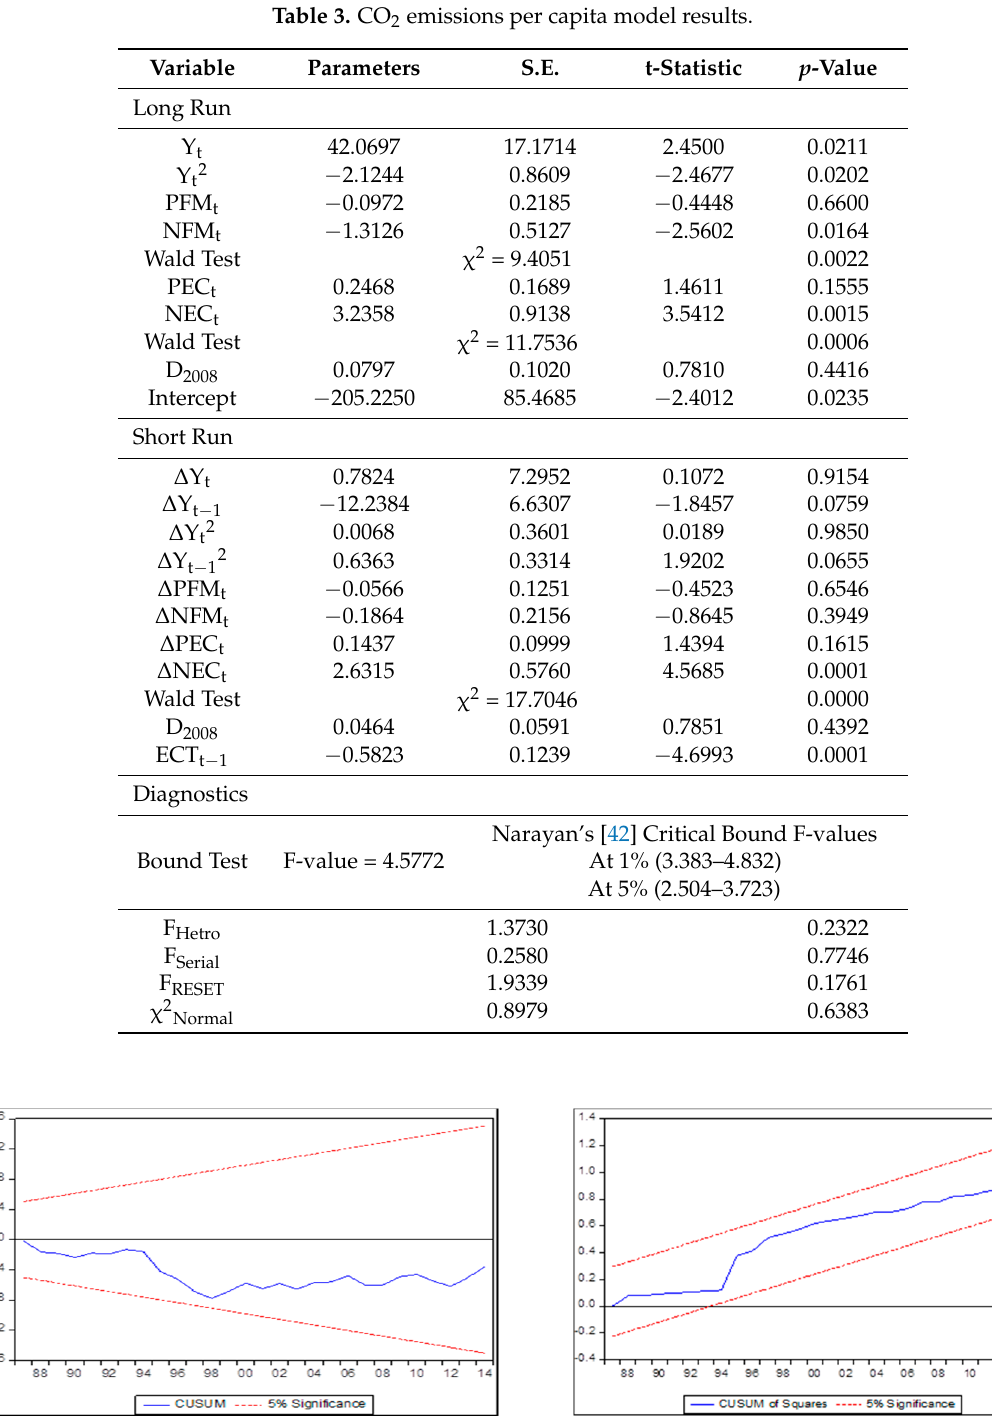
Figure 2. CUSUM and CUSUM of squares Tests.